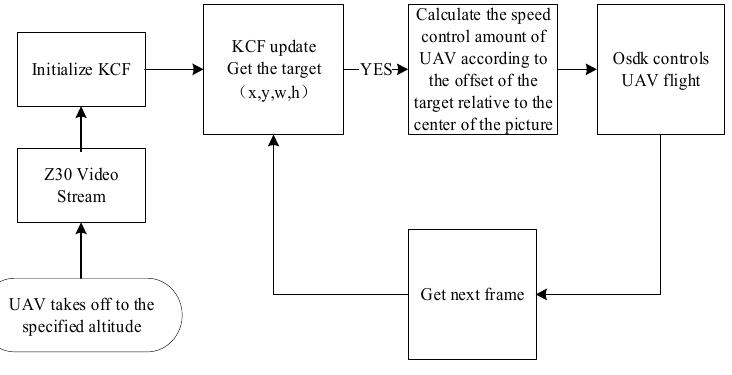
Figure 10. Experimental procedures.